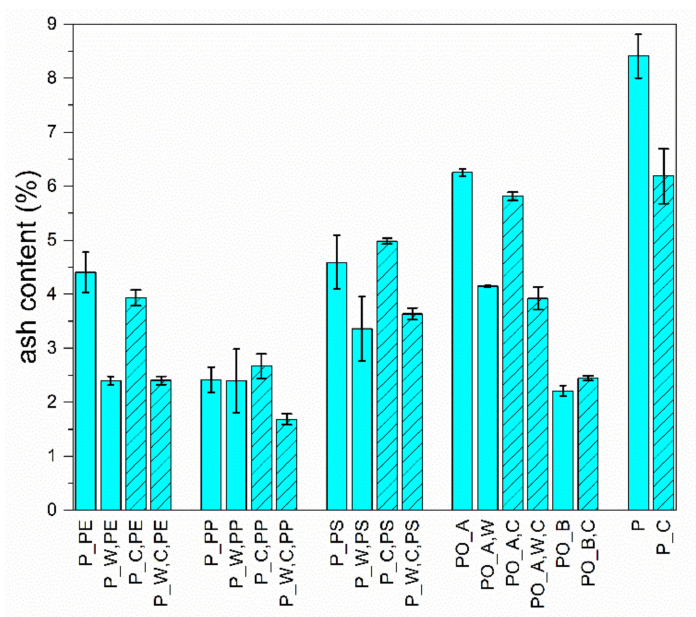
Figure 4. Calculated ash contents of all investigated materials.